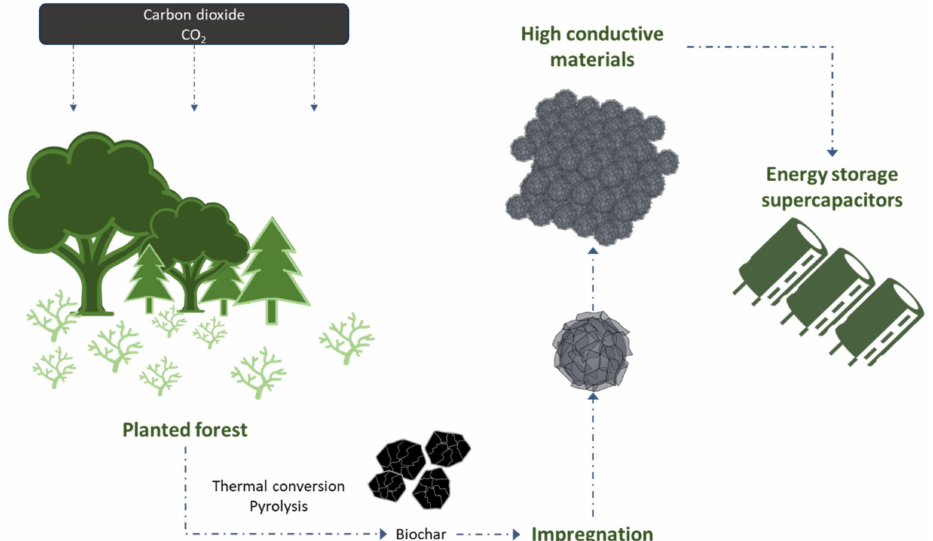
Figure 6. Utilization of biochar in Pickering emulsions and energy